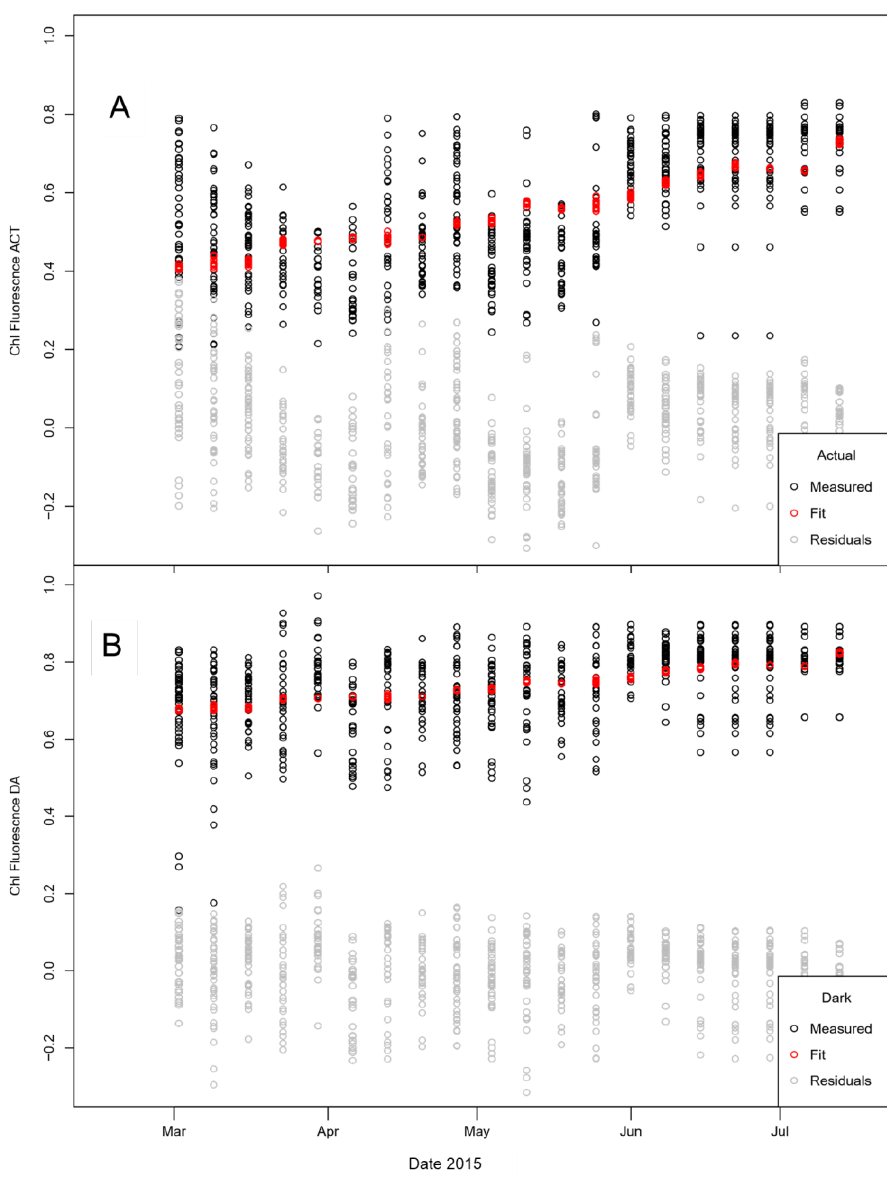
Figure 6. ( A ) Actual and ( B ) dark-adapted chlorophyll a fluorescence measured as F v /F m .